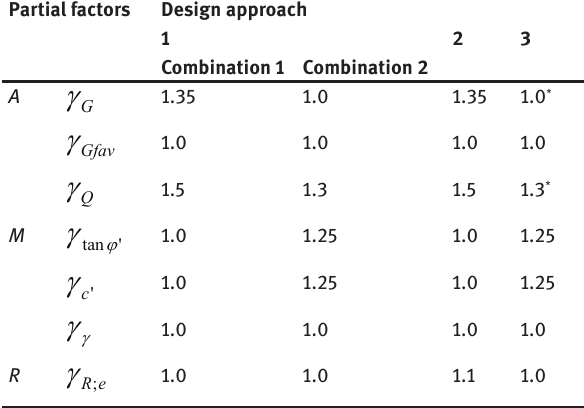
Table 1: Values of partial factors recommended for use in the analysis of slope stability Partial factors Design